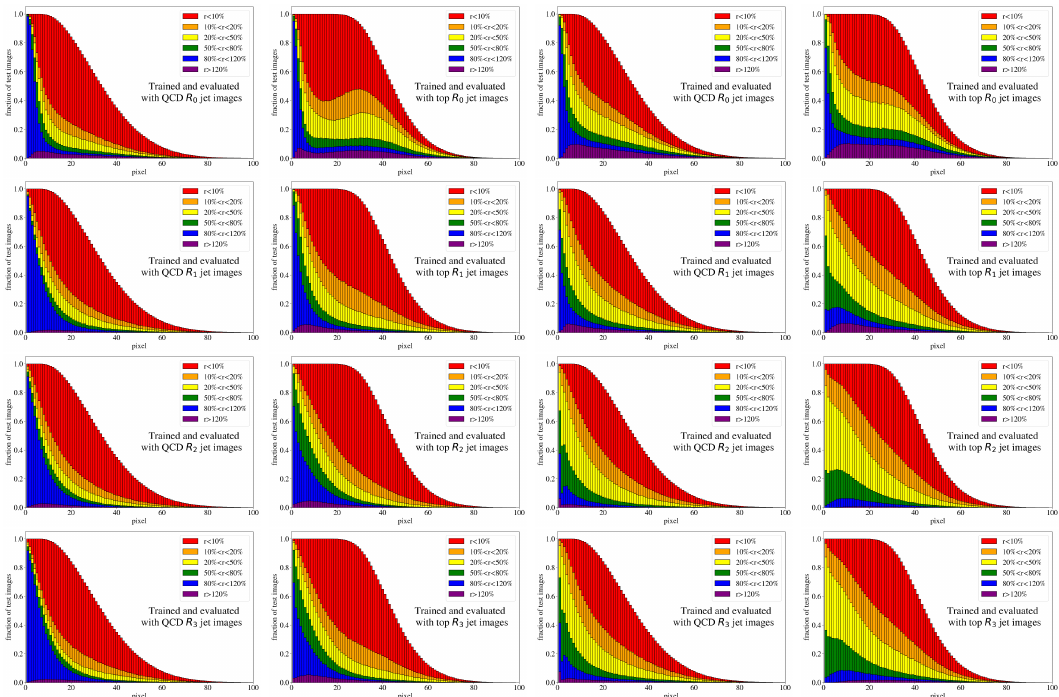
Figure 20 . Stacked histogram for different categories of the ratio r of the reconstructed and the input intensity of the non-zero pixels. Pixels are ordered by intensity from left to right for each of the 40k test jets, cf. figure 4. The first and second columns represent the results for an AE trained on QCD and top jet images, respectively, using MSE loss, while the third and fourth columns show the corresponding results using the KMSE loss function. The rows correspond to the different image remappings R 0 , R 1 , R 2 , and R 3 from top to